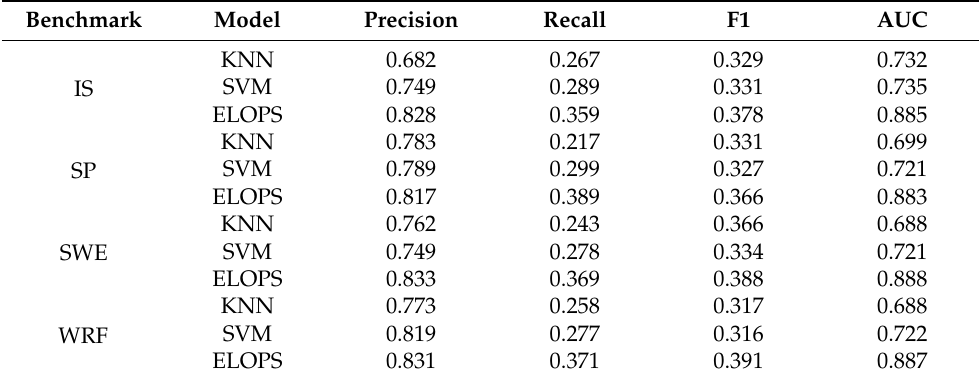
Figure 8. The speedup of the new programs when taking the ELOPS model on Platform II. Table 7. Predicted results of time on the different